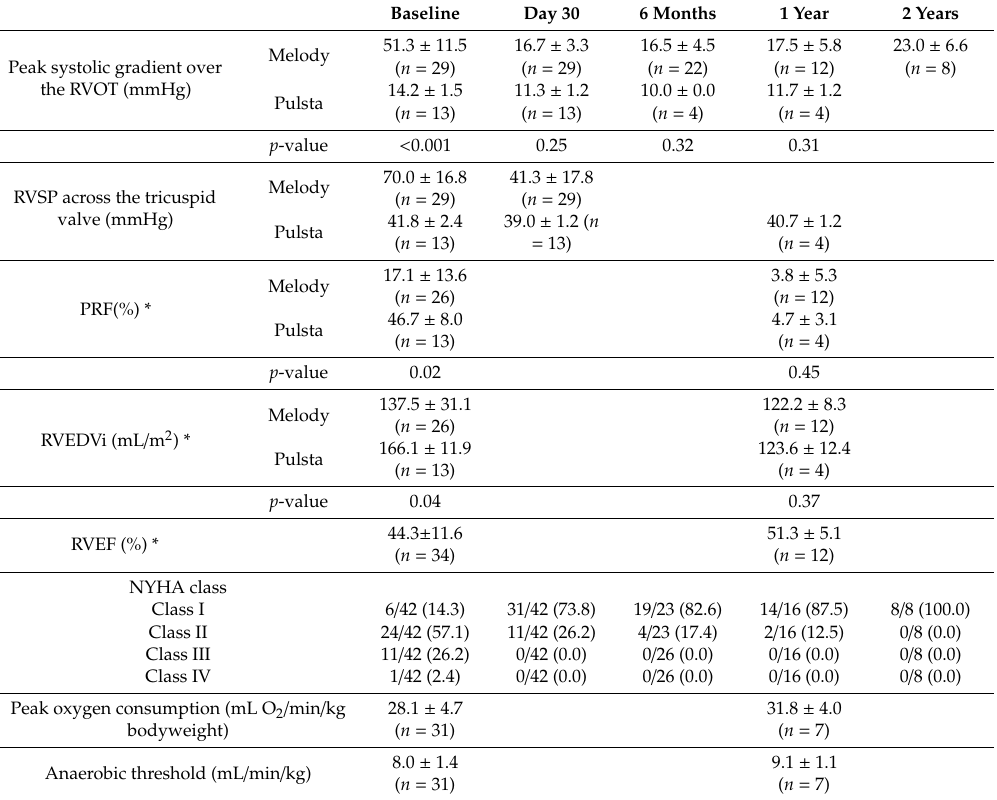
Figure 5. NYHA (New York Heart Association) functional class before and after PPVI (percutaneous pulmonary valve implantation). The NYHA functional class of patients improved to class I in all patients over time. Table 4. Hemodynamic and functional improvements following percutaneous pulmonary valve implantation